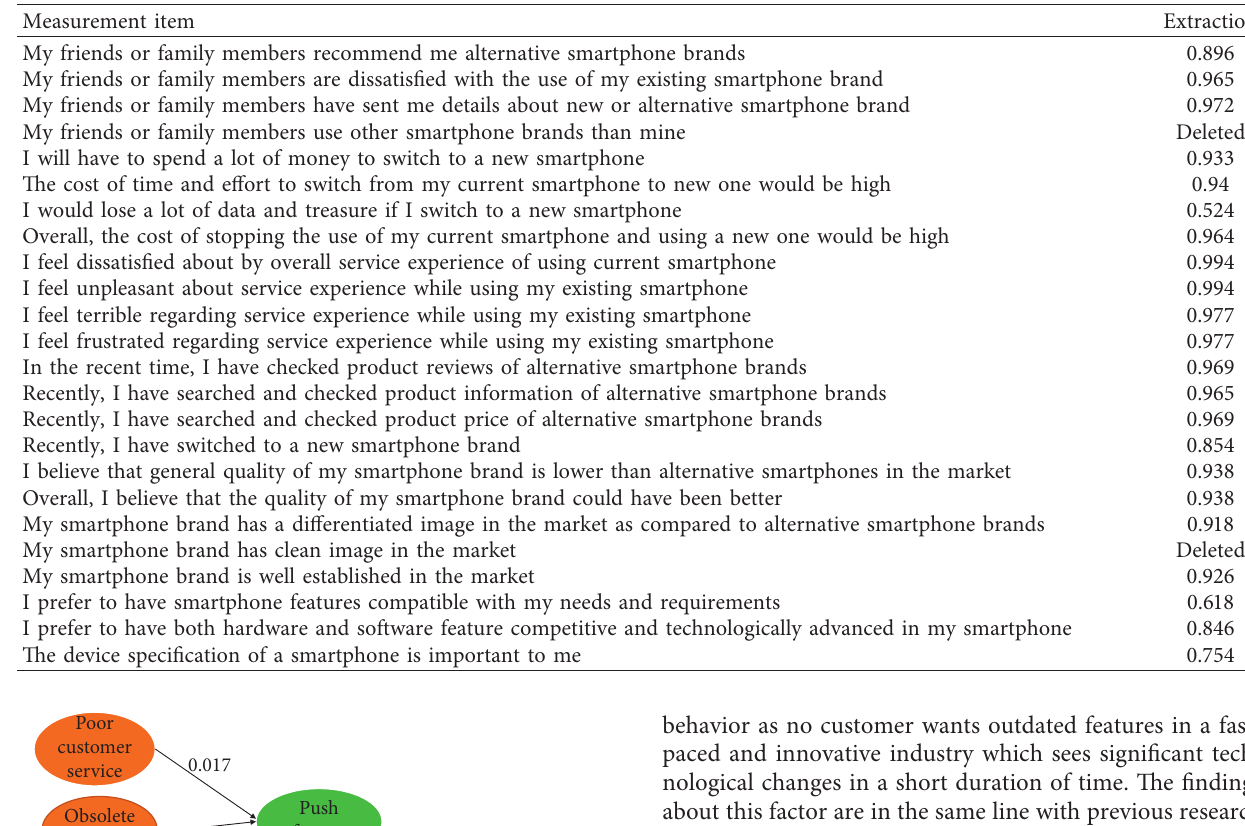
Table 5: Factor loadings.